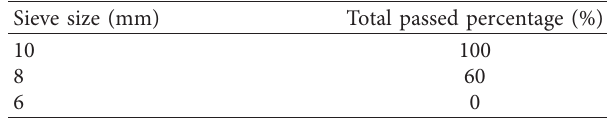
Table 1: Coarse aggregate size